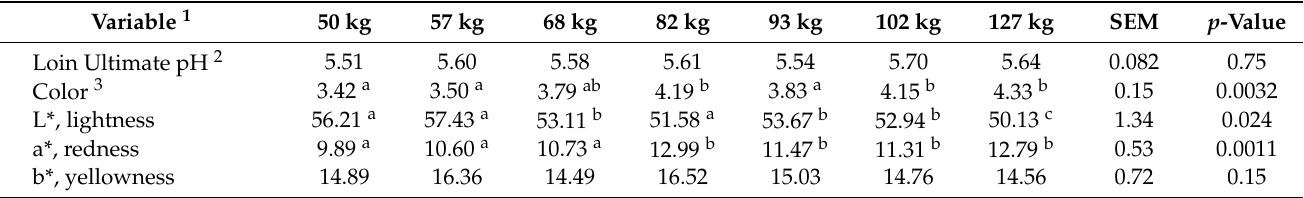
Table 2. Loin 24 post-harvest pH and color of Mangalica pigs at different weight classes.